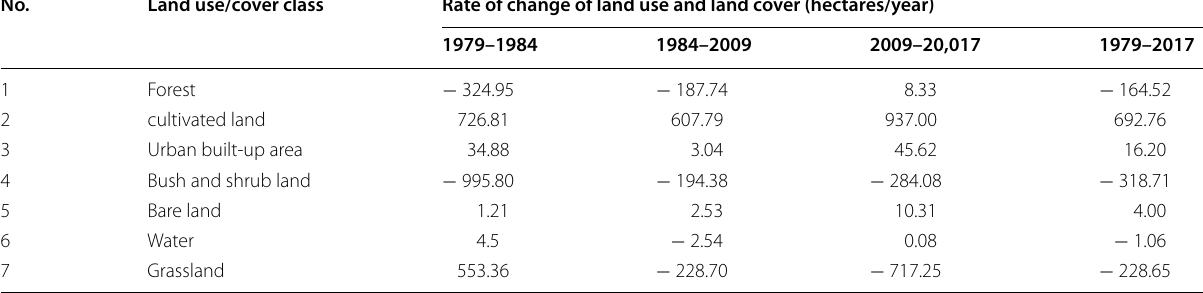
Table 5 Rate of changes of land use and land cover in Huluka Watershed (ha/year)